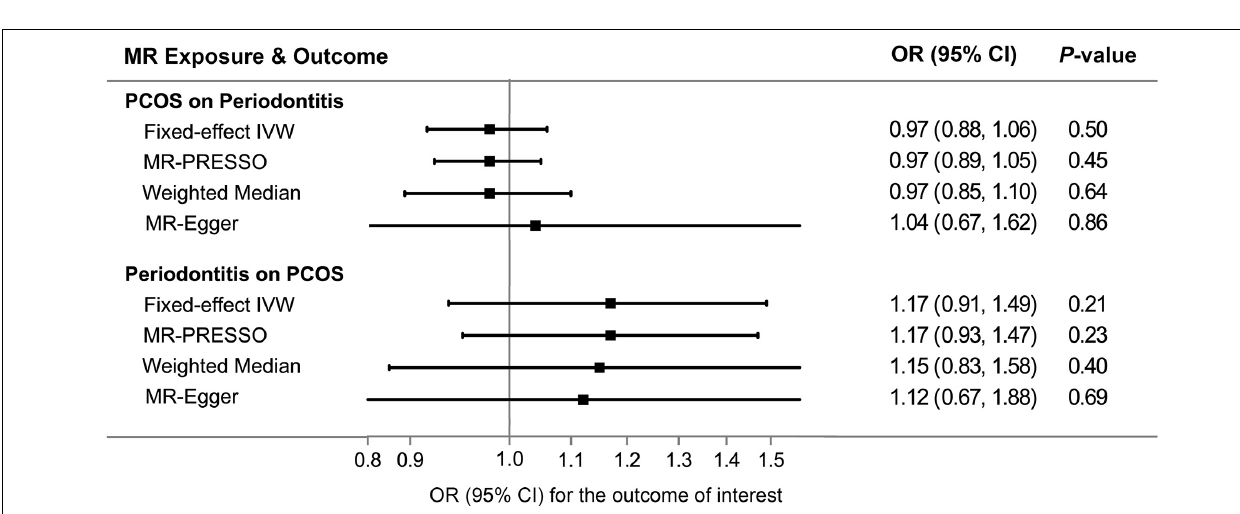
FIGURE 2 | Primary results by Mendelian randomization analysis using the inverse-variance-weighted method. The causal estimate (overall fitted line) for the effect of PCOS on periodontitis was shown in panel (A) , while the overall effect for the casual association of periodontitis with PCOS was presented in panel (B) . Individual SNP-effect on the outcome (point and vertical line) against its effect on the exposure (point and horizontal line) was delineated in the background. CI, confidence interval; IVW, inverse variance weighted; OR, odds ratio; PCOS, polycystic ovary syndrome; SNP, single nucleotide polymorphism.